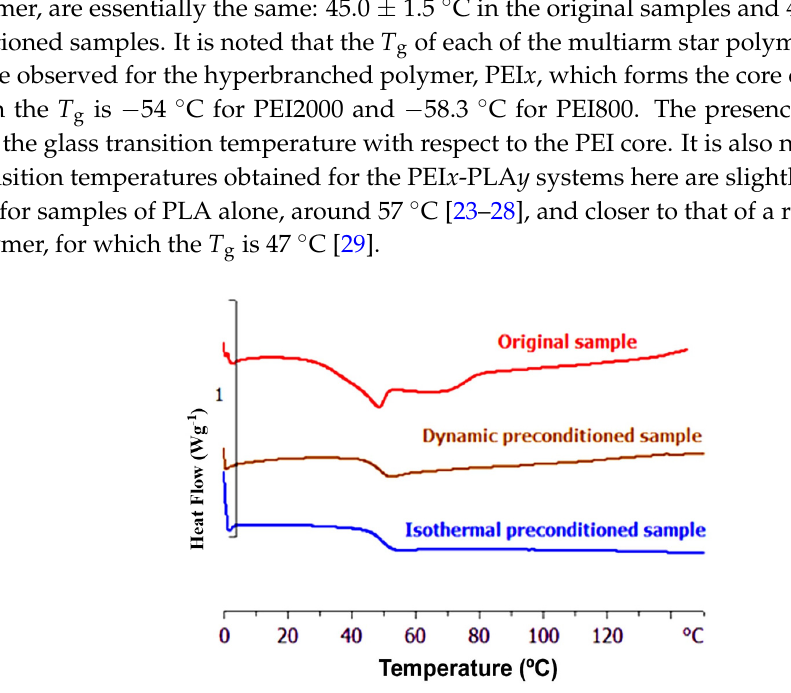
Figure 3. Differential scanning calorimetry (DSC) plots of heat flow (Wg − 1 ) as a function of temperature (°C), at a heating rate of 10 °C/min, for PEI2000-PLA5 in the original and preconditioned states. The heat flow scale ( y -axis) is relative, and the curves have been separated for clarity.